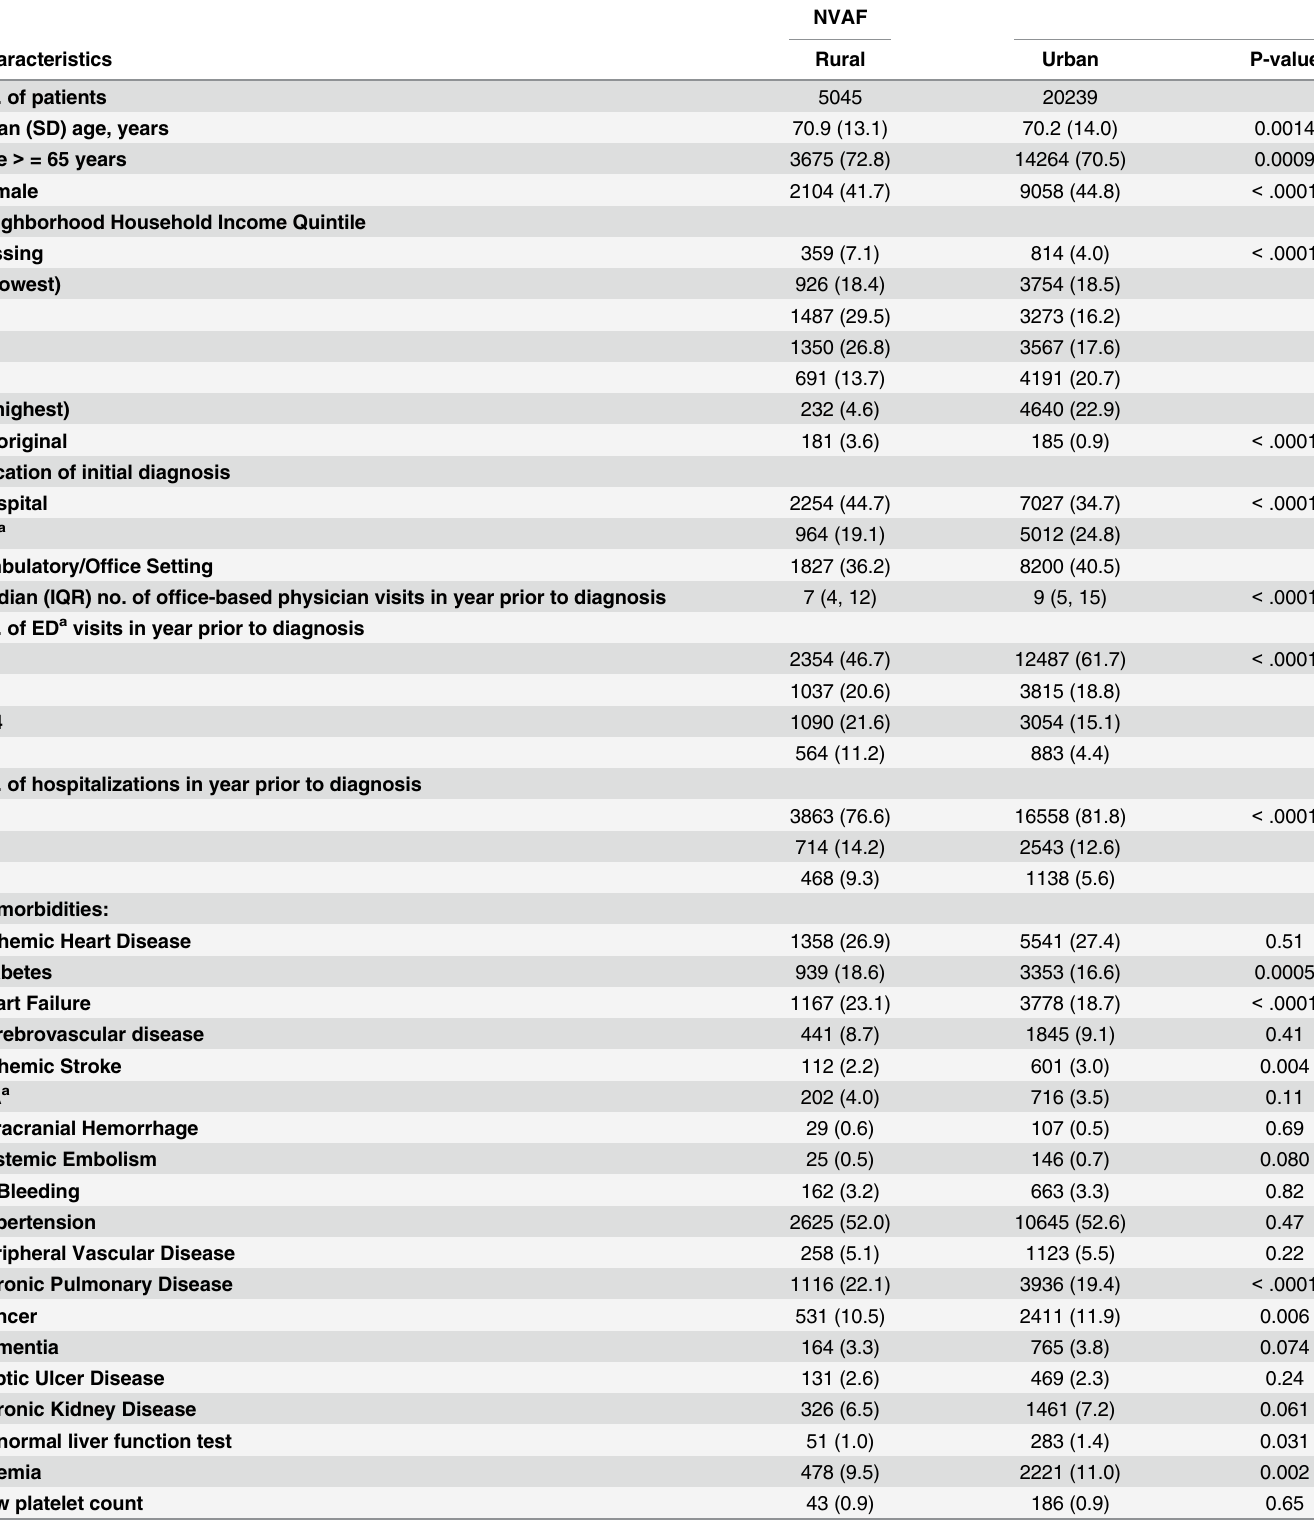
Table 1. Baseline Characteristics of N = 25,284 Rural and Urban Residents with incident non-valvular atrial fibrillation